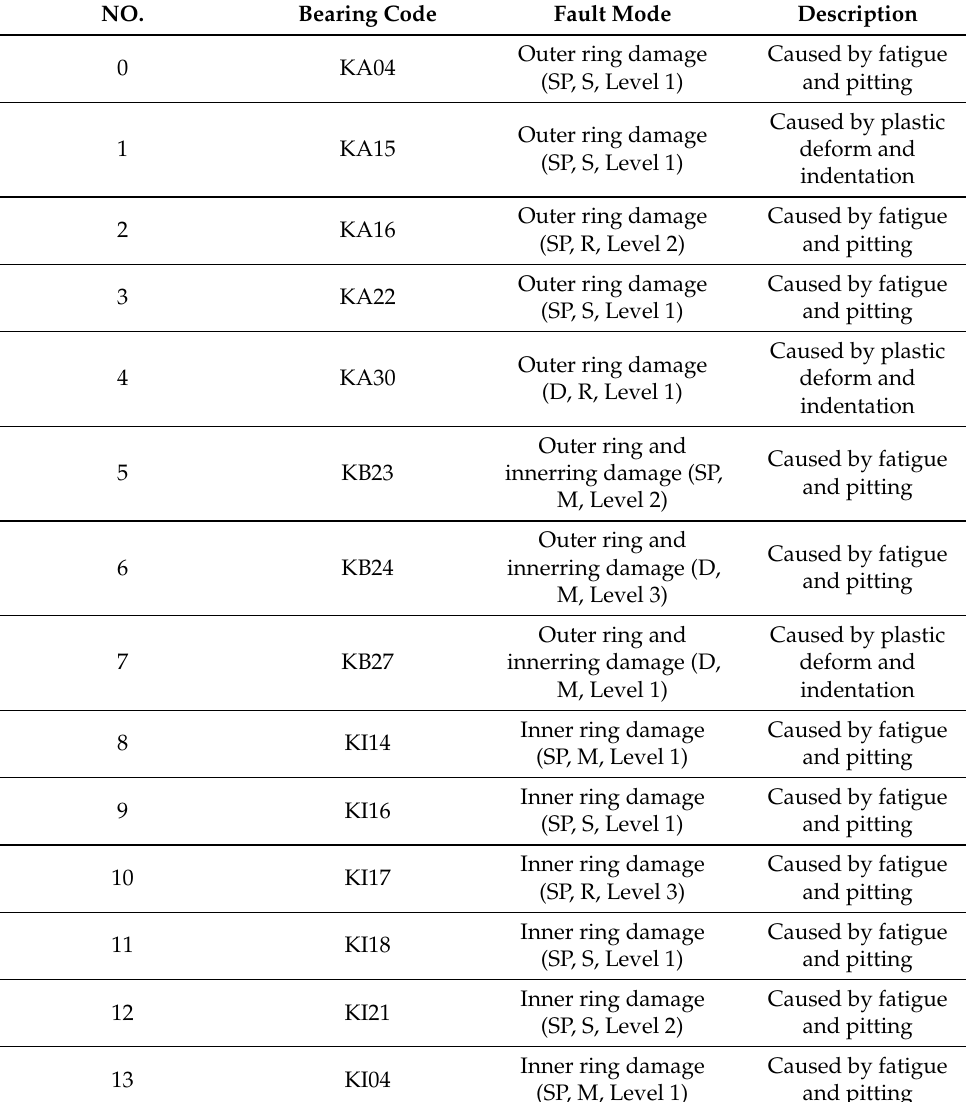
Table 7. Detailed description of PU